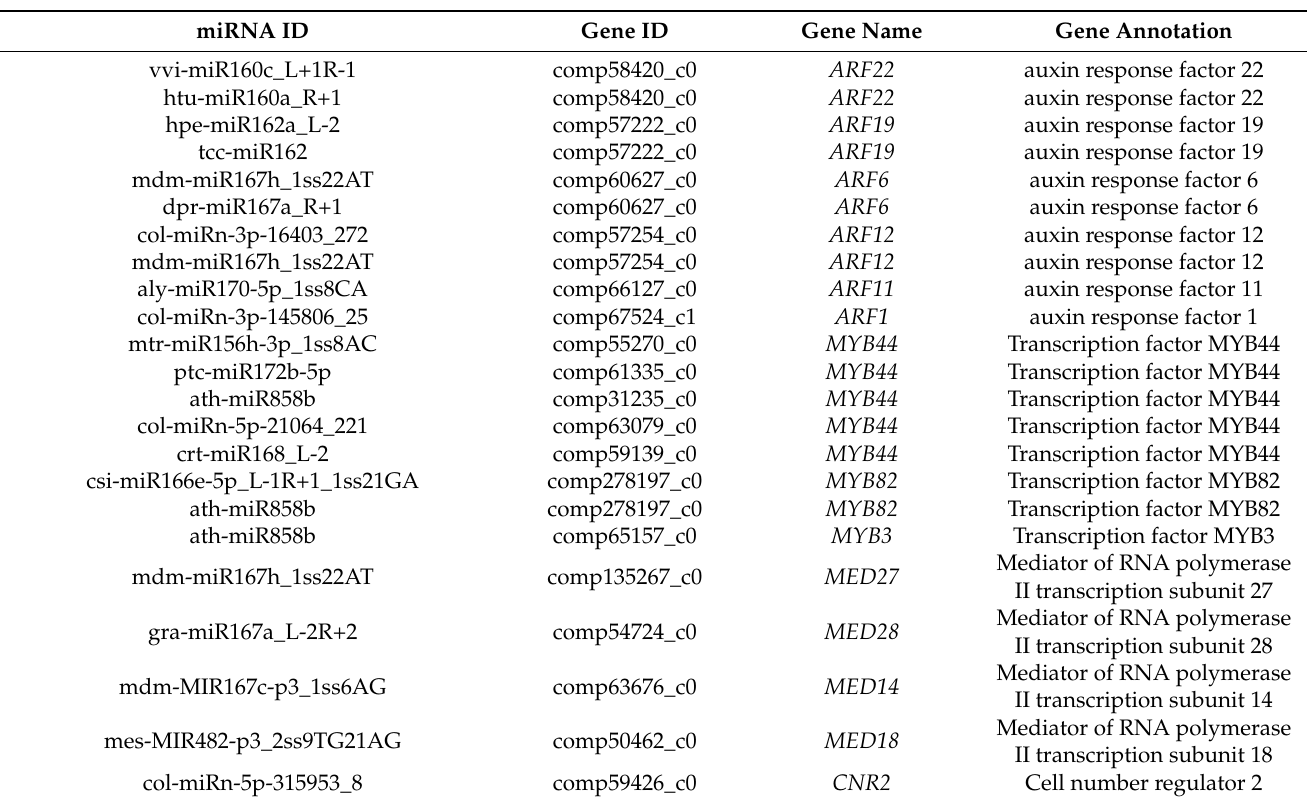
Table 2. Predicted miRNAs and their target genes involved in seed